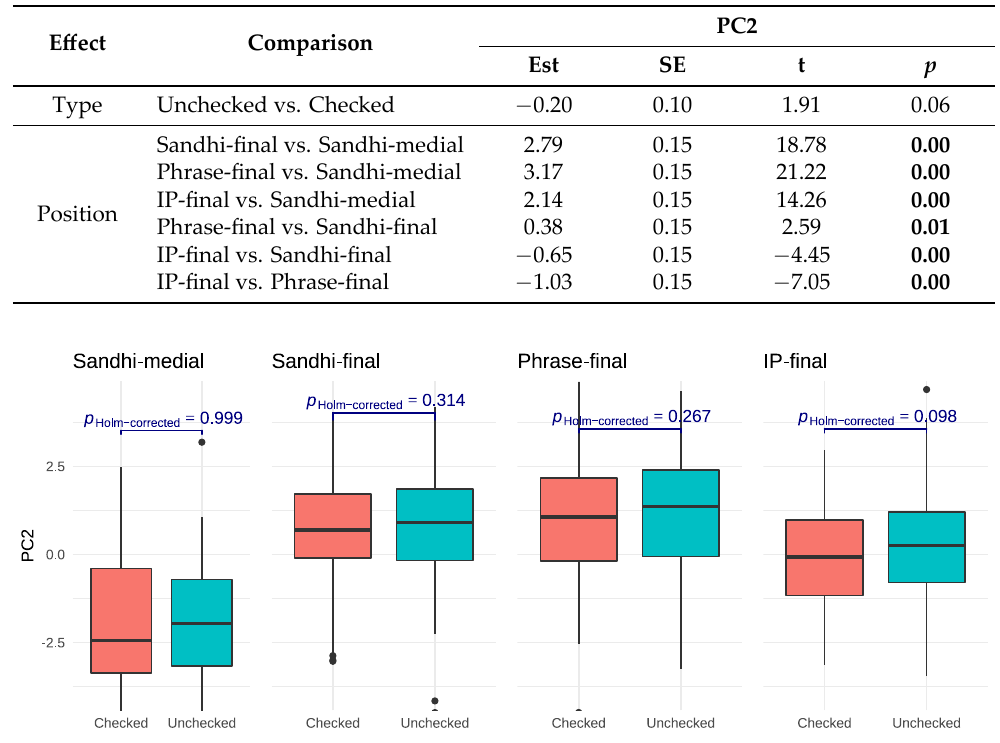
Table 3. Outputs of linear mixed‑effect regression for PC2 without interaction effects. Significant p ‑values ( p ⩽ 0.05 ) are marked in bold.